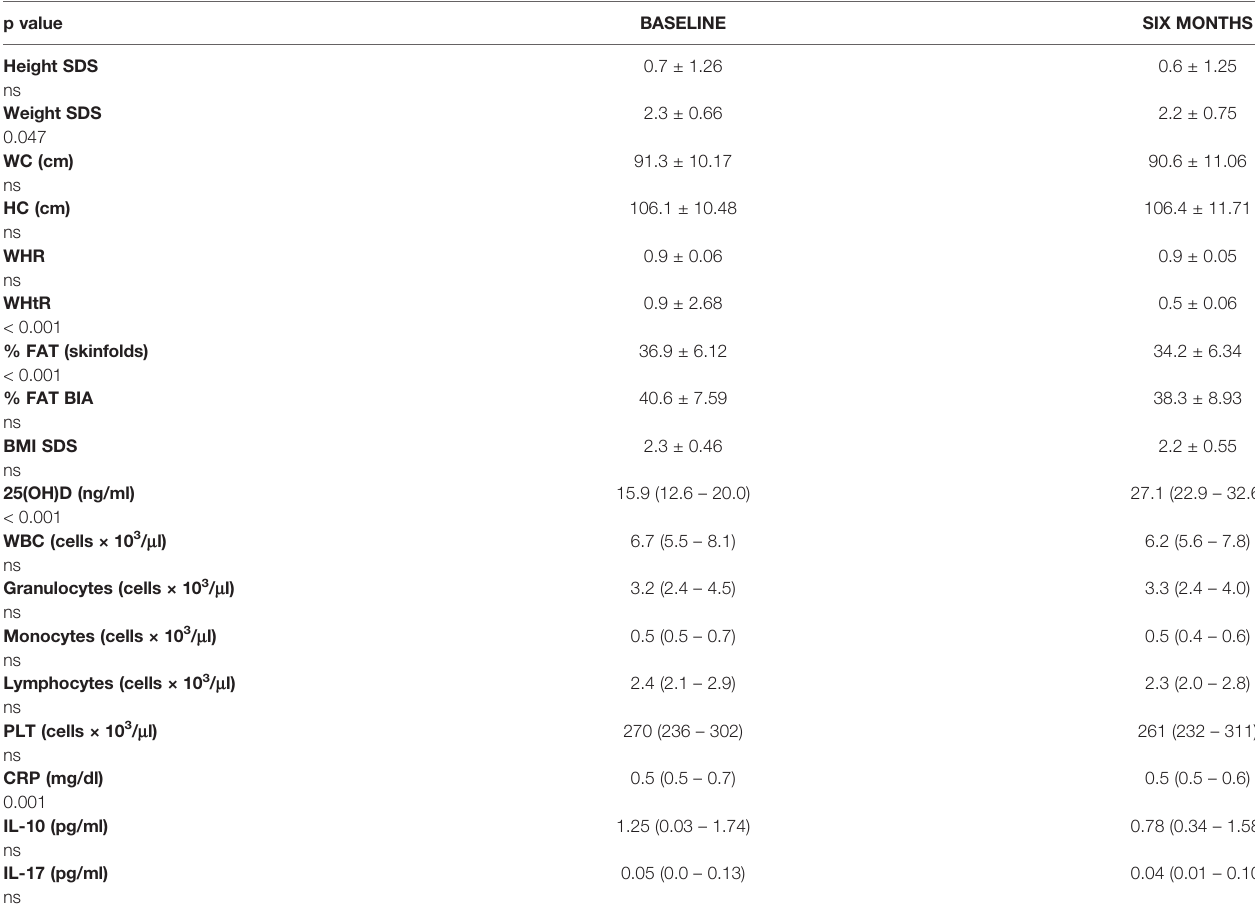
TABLE 2 | Comparison between anthropometric measurements, haematological, and biochemical parameters in the study group at baseline and after six months of vitamin D supplementation. p